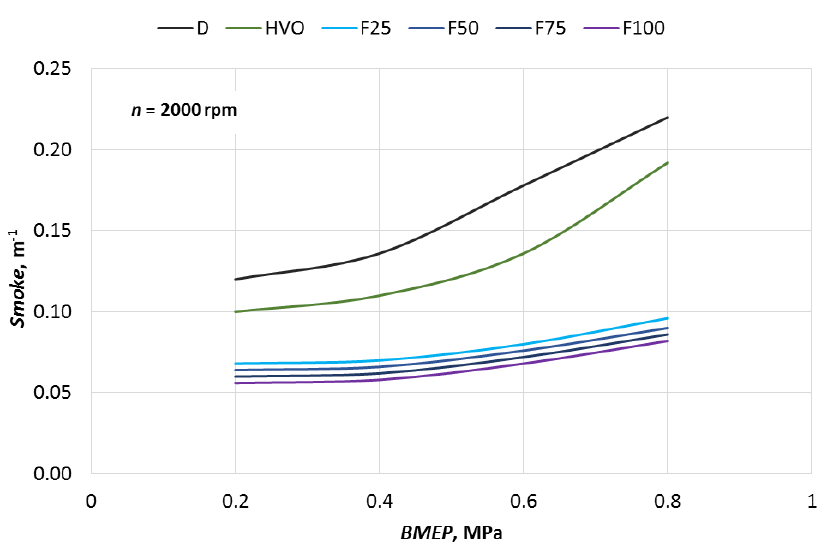
Figure 10. Dependence of smoke emissions on the load using different fuels.